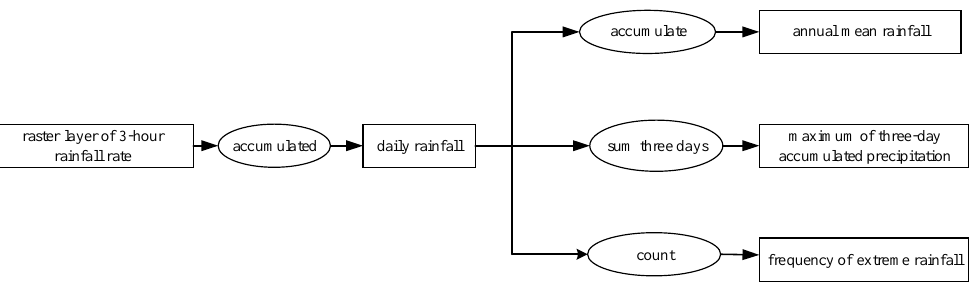
Figure 10. Flow chart of rainfall raster processing.